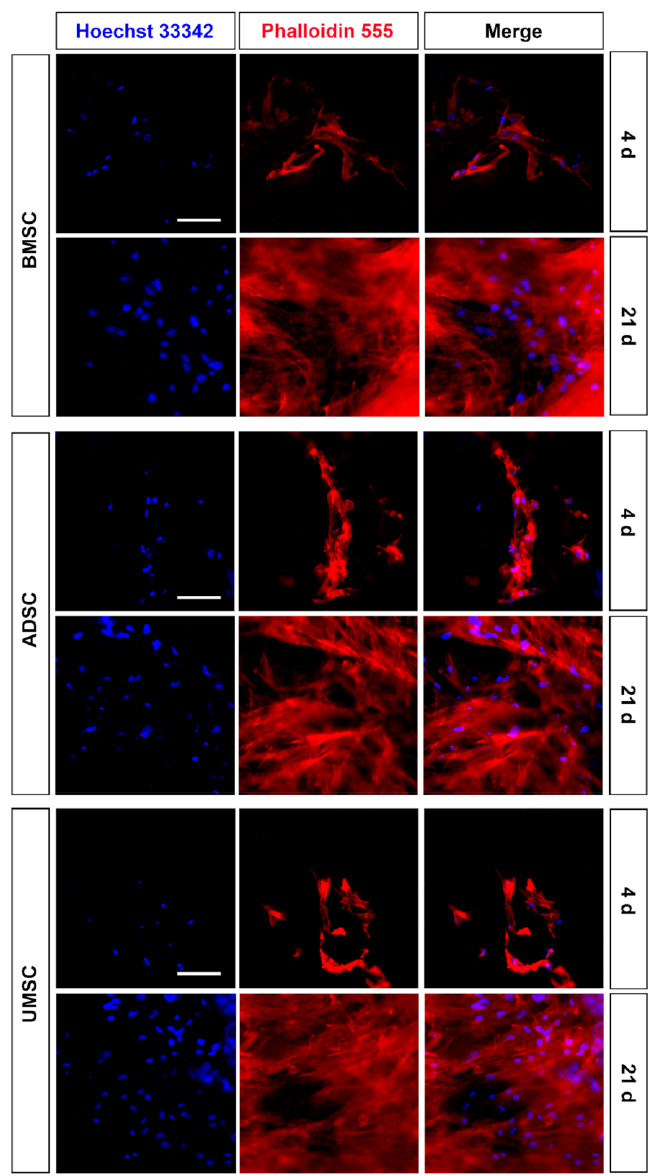
Figure 2. Identification of proliferation and adhesion of hMSCs on hDCB blocks. The left panels displayed nuclear staining, the middle panels showed F-actin staining, and the right panels displayed merged channels. F-actin and nuclei were stained with Phalloidin 555 (red) and Hoechst 33,342 (blue), respectively. Scale bars are 50 µ